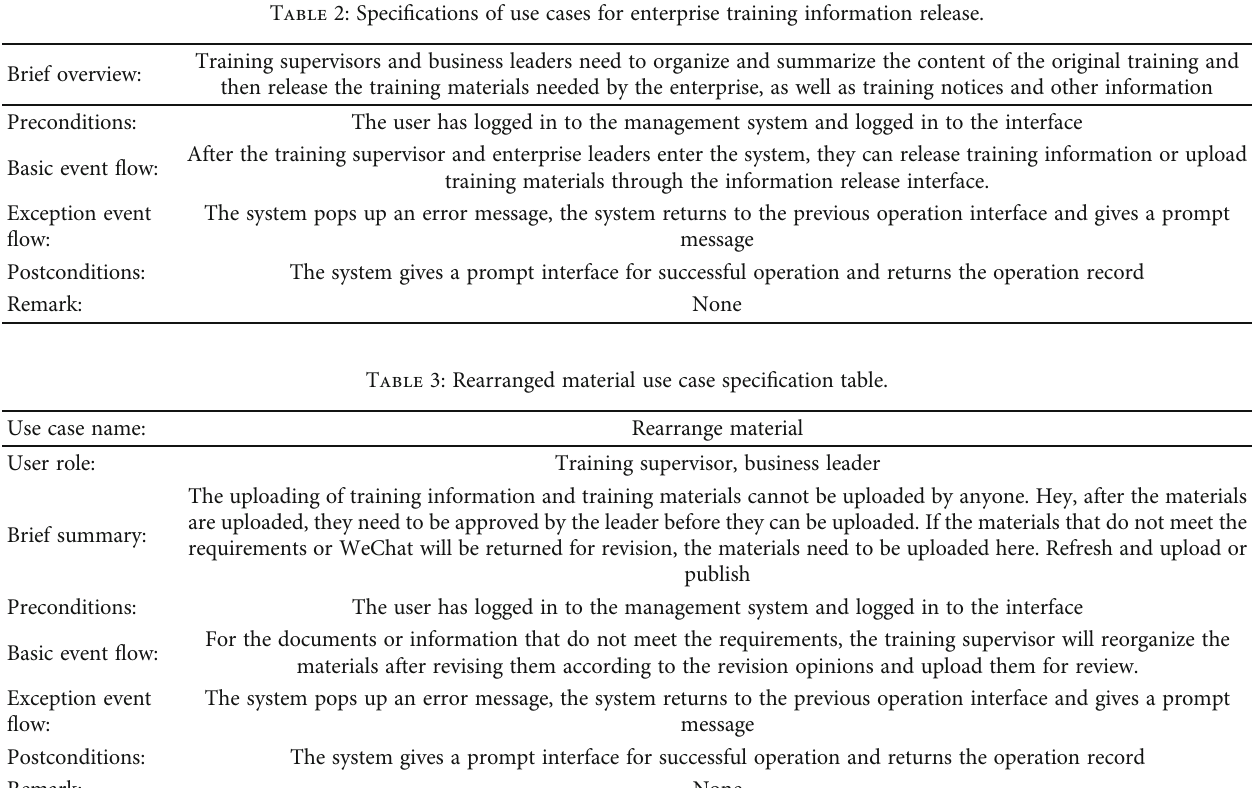
Table 2: Speci fi cations of use cases for enterprise training information release.